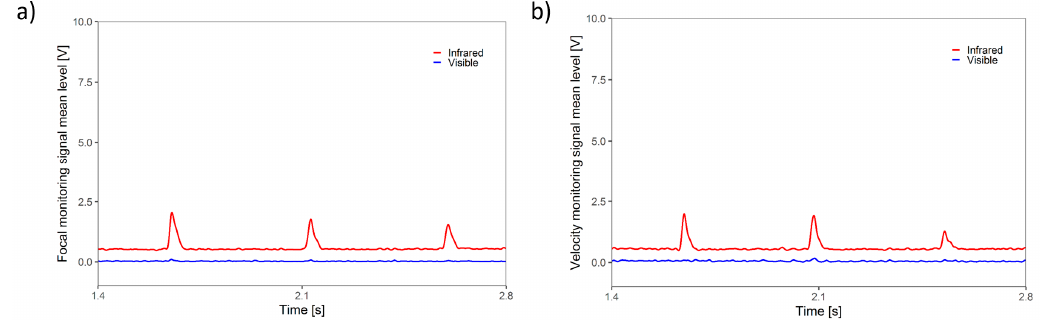
Figure 6. VIS (gain 4) and IR (gain 2) monitoring mean levels obtained during the laser cutting of aluminum of 5 mm with nitrogen, with: ( a ) focal position of − 0.6 mm; ( b ) velocity of 7500 mm/min.